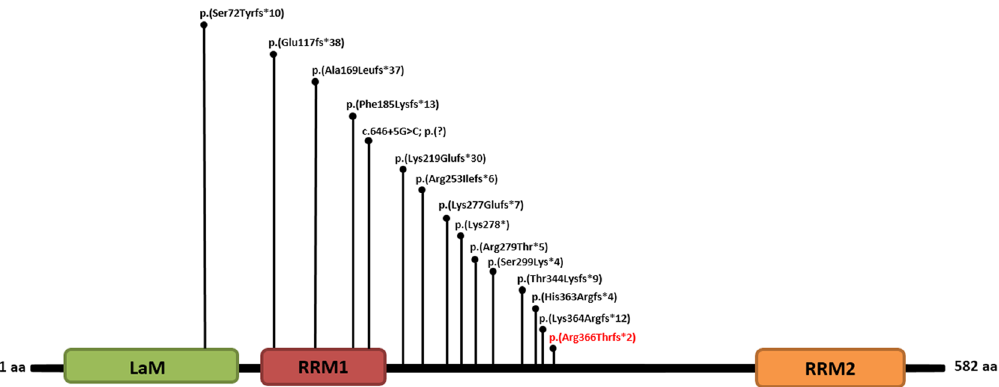
Figure 3. Schematic representation of the protein domains of La-related protein 7 [20,21], encoded by LARP7 , with positions of all known deleterious variants published to date and including the present one [4,5,19,22–26]. The variant identified here is in red. (LaM, Lupus antigen Motif; RRM1, RNA Recognition Motif 1; RRM2, RNA Recognition Motif 2).